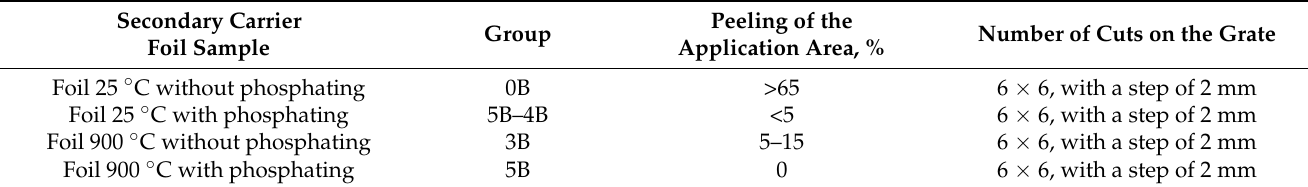
Table 5. Coating adhesion test results of secondary carrier foil